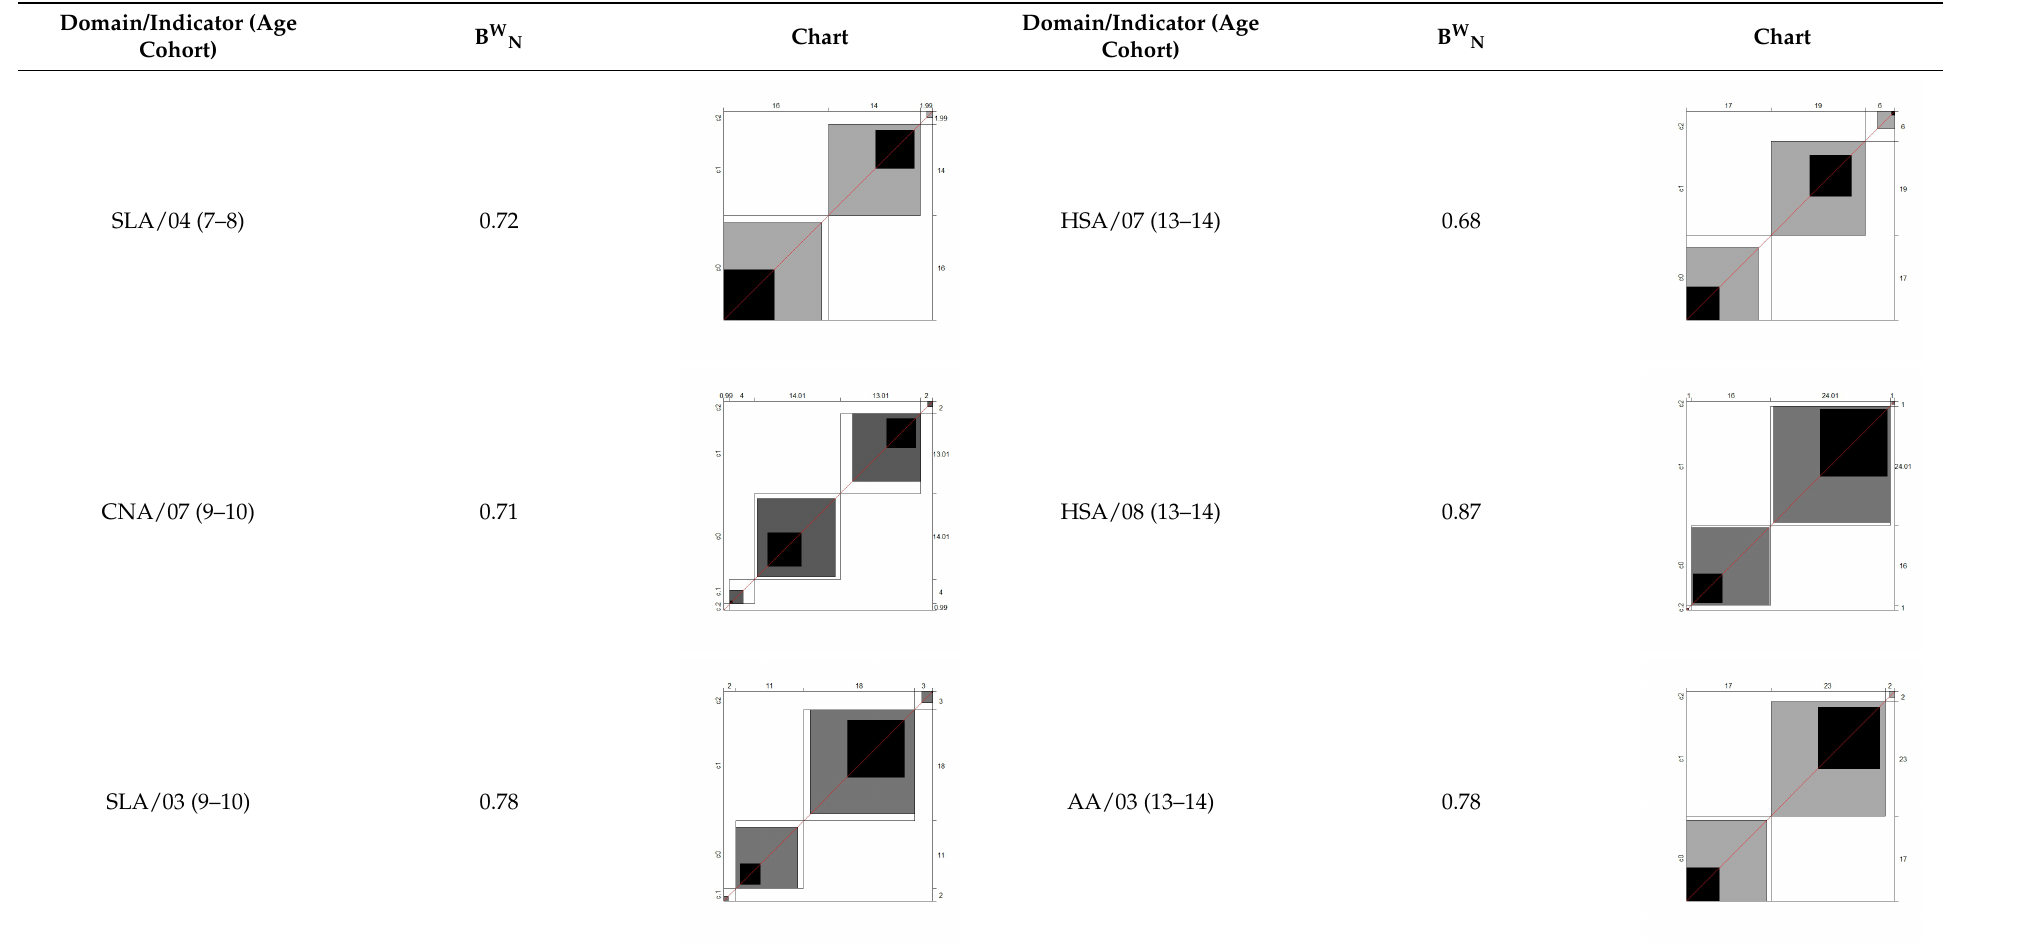
Table 5. Indicators showing weak evidence on content validity (age cohorts and